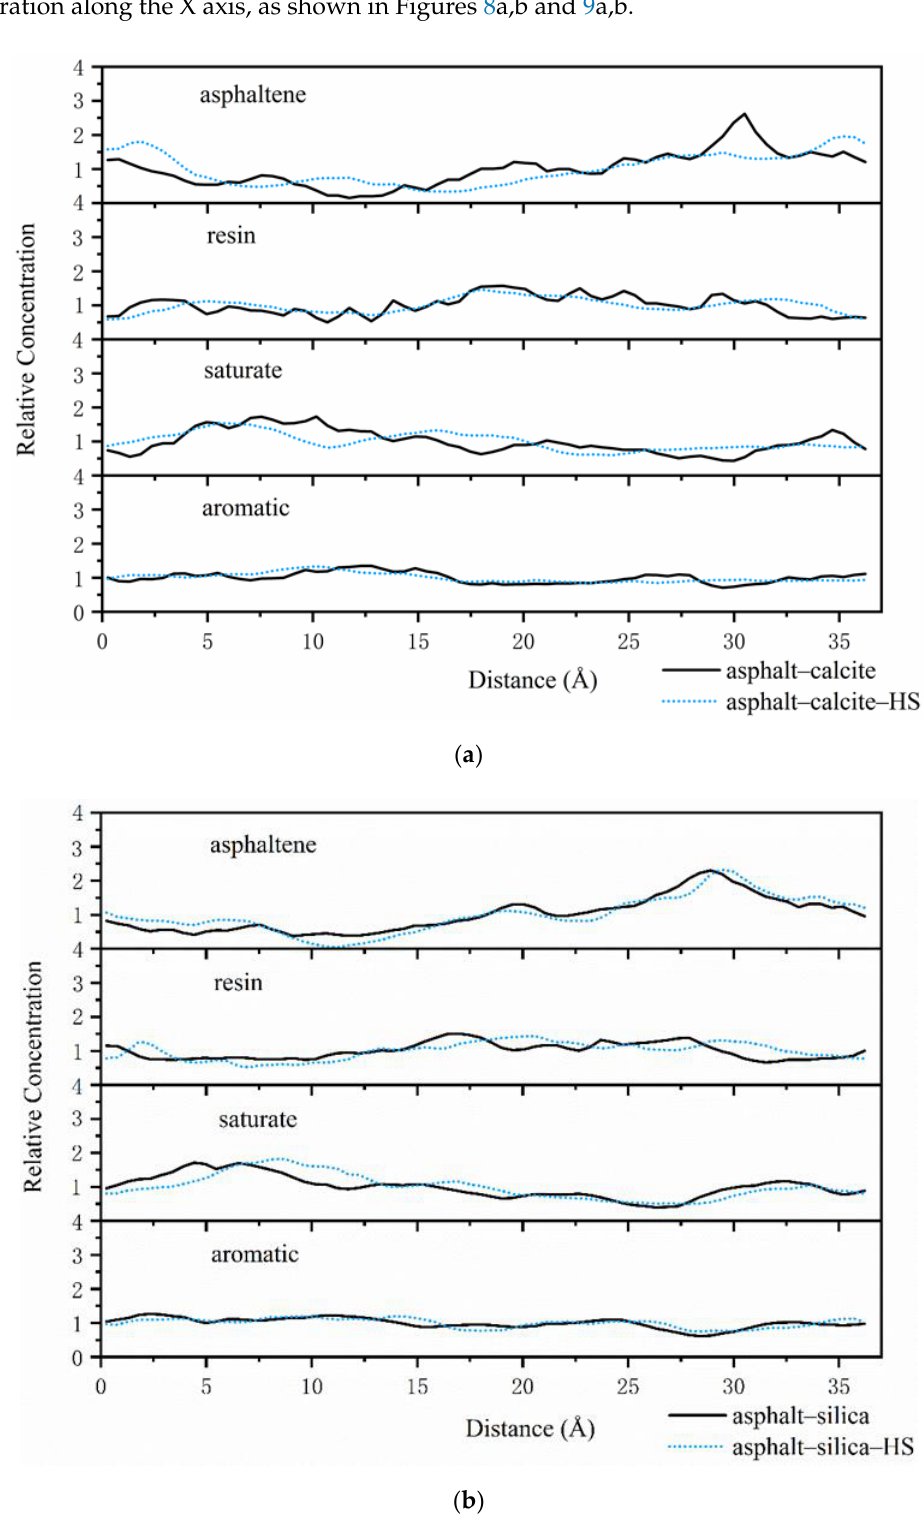
Figure 8. Asphalt–aggregate interface relative concentrations with and without adsorbed water on the aggregate surface: ( a ) asphalt–calcite and ( b ) asphalt–silica.